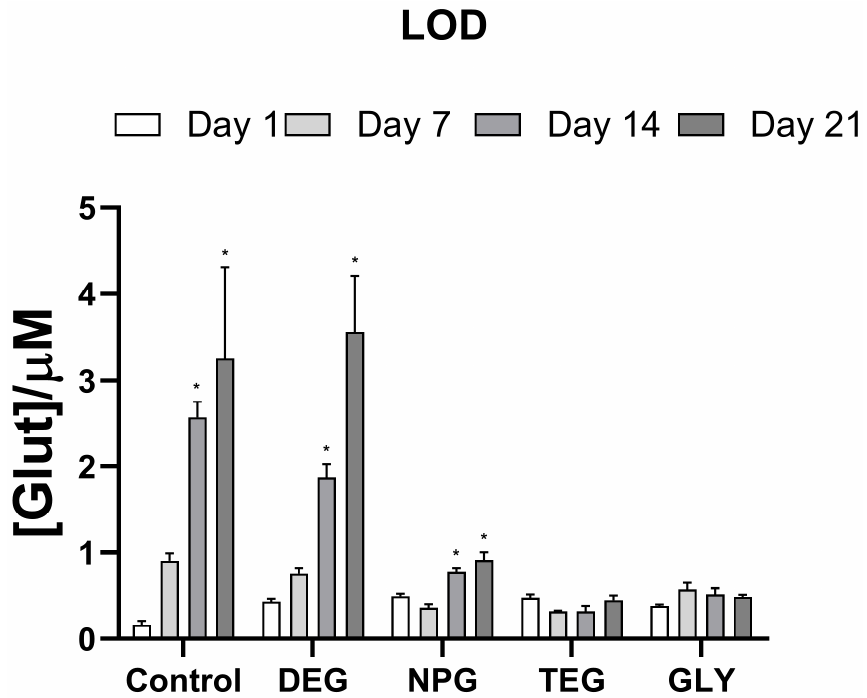
Figure 6. Bar plot of the variation of LOD for different biosensor designs (n = 4): Pt c /PPD/PEI(1%) 2 /GlutOx 5 /Glycol(0.1%). Pt c : Pt cylinder 1 mm long; GlutOx: L-glutamate oxidase; PPD: ortho-phenylenediamine polymer; PEI: polyethyleneimine, DEG: diethylene glycol, NPG: neopentyl glycol, TEG: triethylen glycol, GLY: glycerol. The subscript number represents the number of dips and in brackets, the concentration of the glycol. Values are expressed as mean ± SEM. * p < 0.001 vs. Day 1 of the respective group.